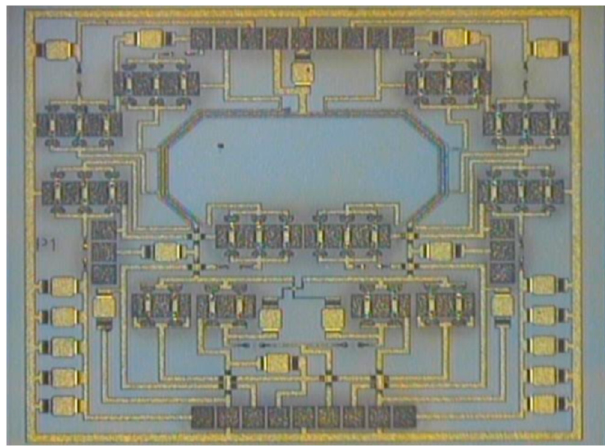
Figure 5. Photograph of the switched inductor VCO.